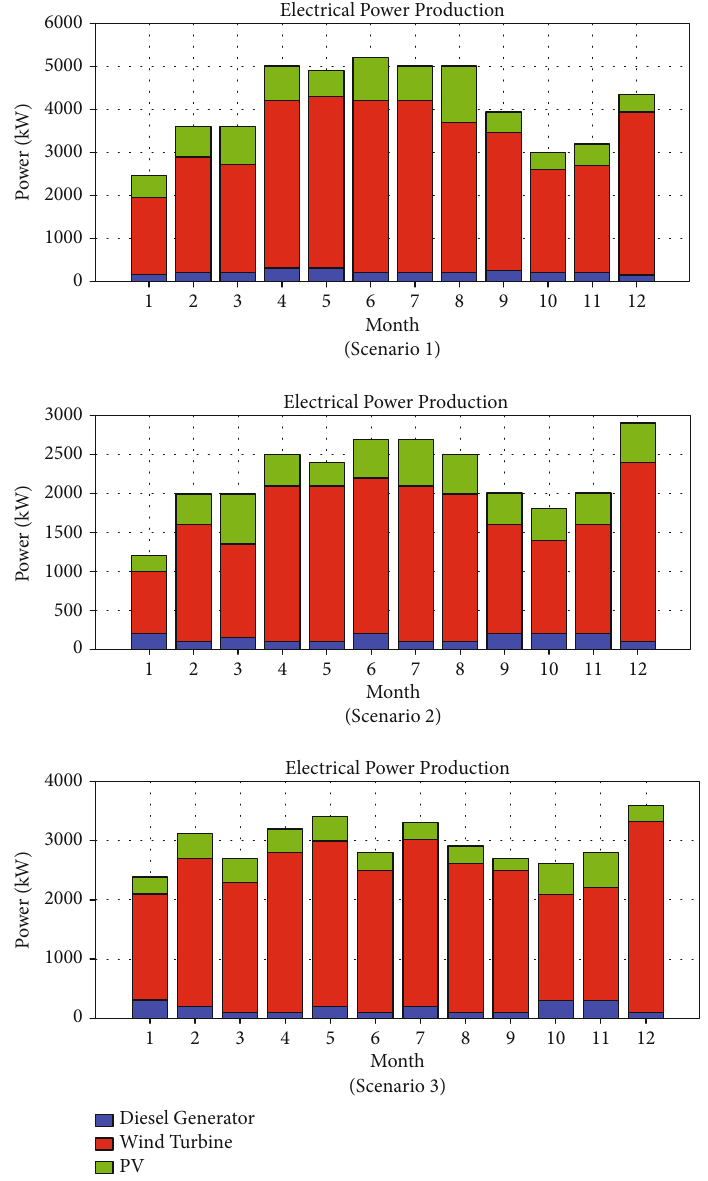
Figure 4: Designed IHMS for 12 months. This fi gure is reproduced from Shezan et al.